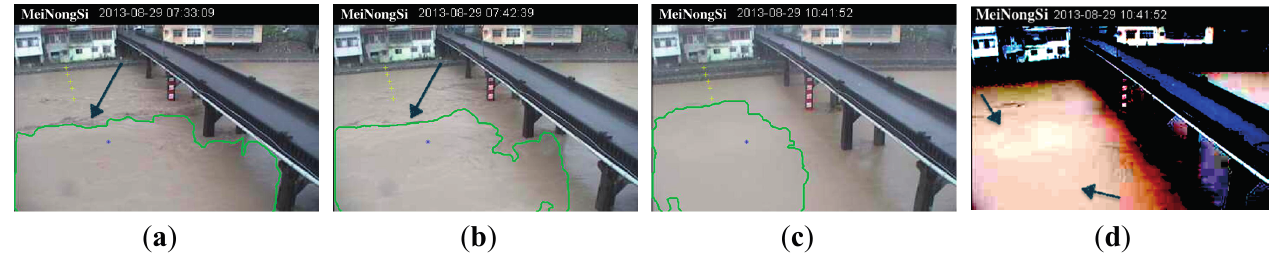
Figure 5. Real-time field images and analysis data of the flood level. In this case, only five virtual markers were set from the riverbed to the embankment top. ( a – h ) show the visual sensing results from screen shots every 50 min; and ( i ) the graph generated using the number of the virtual markers covered by the waterbody against time.